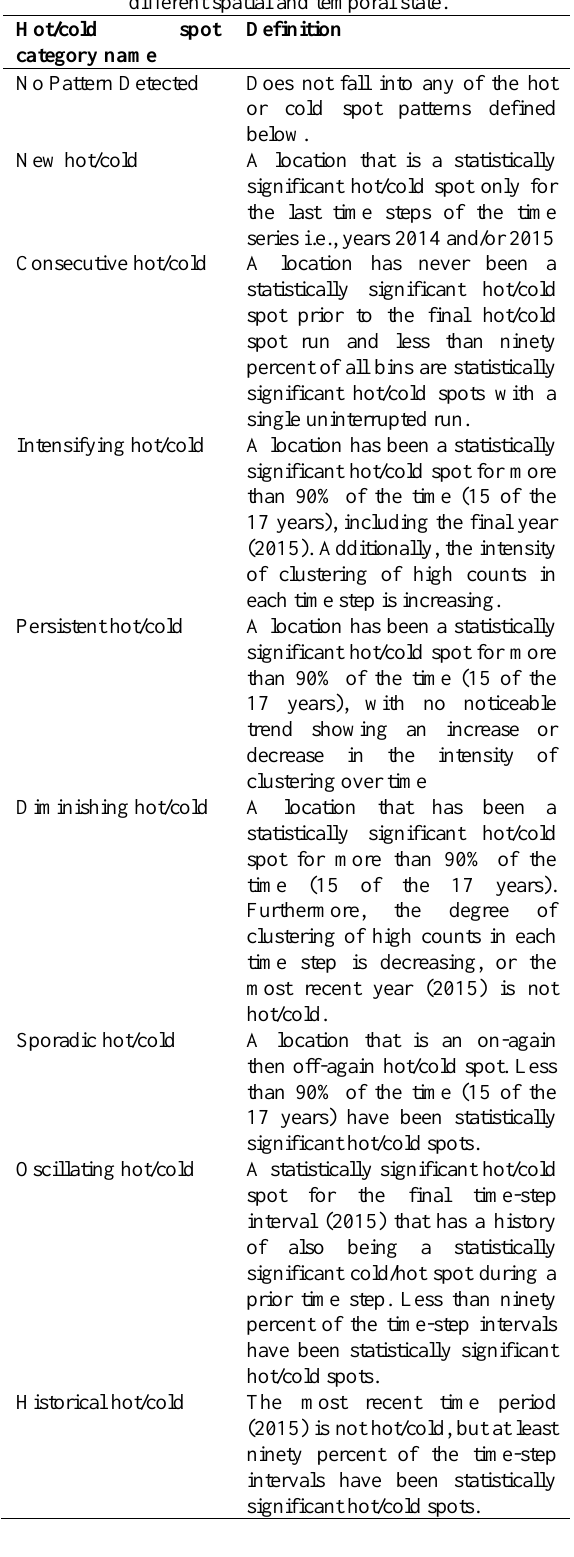
Table 1 Classification system describing various categories of statistically significant hot/cold spots designating different spatial and temporal state.